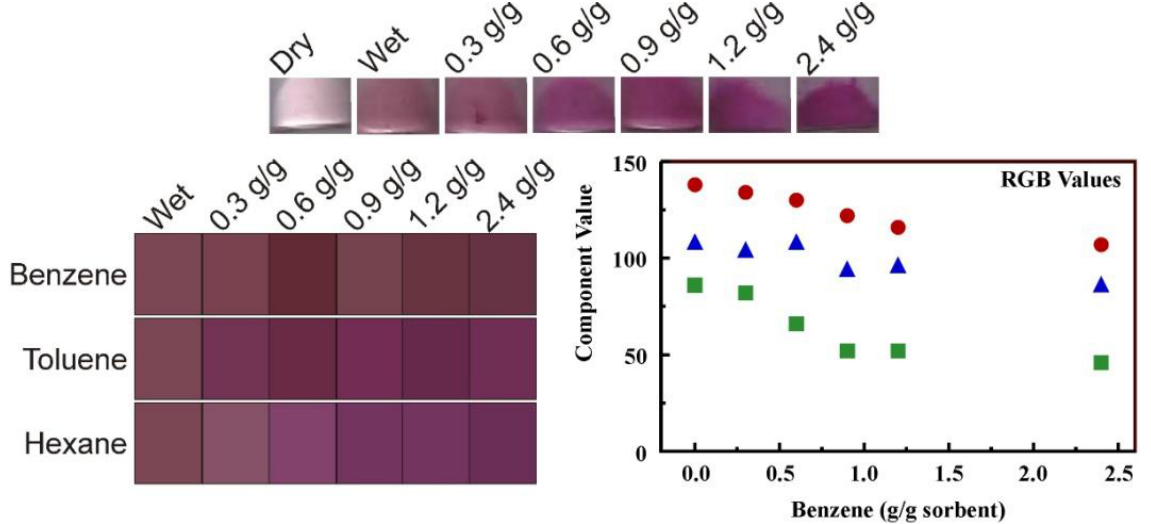
seven spectra: white, red, blue, green, cyan, magenta, and yellow (Supporting Information, Figure